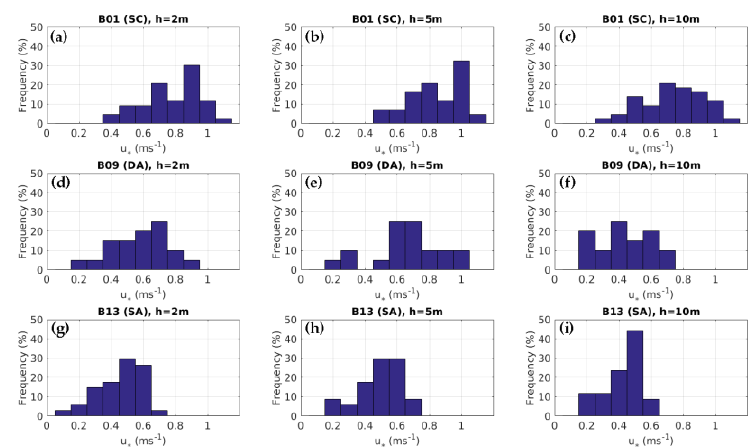
Figure 16. Frequency distribution of friction velocity for: the B01 ( a – c ), B09 ( d – f ), and B13 ( g – i ) bora episodes; at three different vertical levels: 2 m ( a , d , g ), 5 m ( b , e , h ), and 10 m ( c , f , i ).